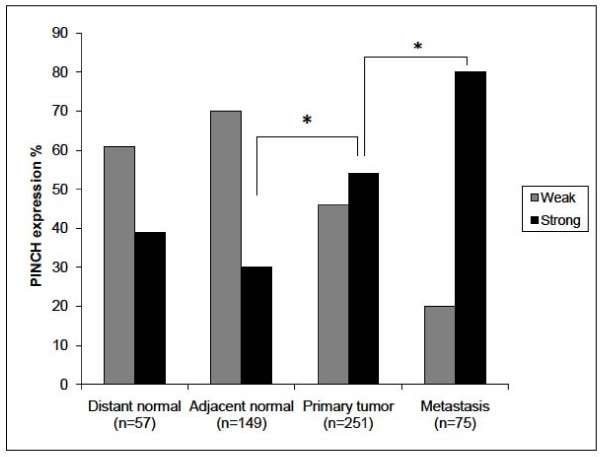
PINCH expression in distant and adjacent normal mucosa, primary tumour and lymph node metastasis. The frequency of the strong PINCH expression is significantly increased from adjacent normal mucosa to primary tumour (p = 0.0001) and from primary tumour to metastasis (p = 0.007).